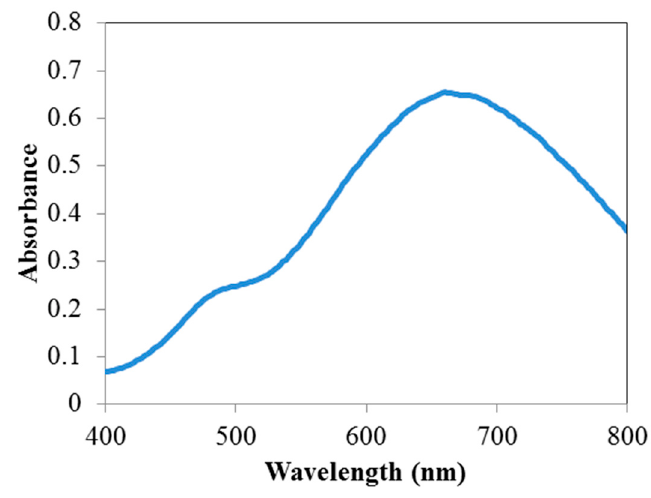
Figure 1. Absorbance spectrum of the as-prepared silver nanoparticle (AgNP) reagent solution before exposure to mercury (II) ion.